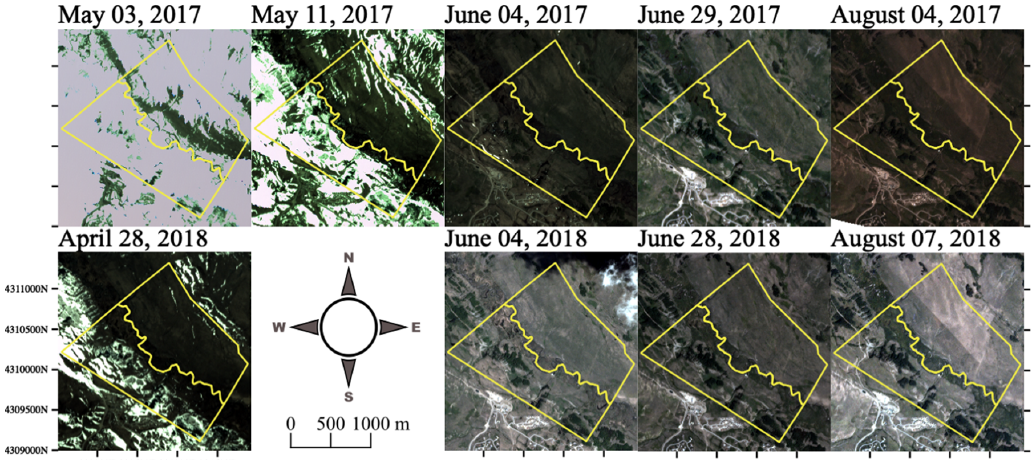
Figure 2. A portion of the time series of true color (RGB) satellite imagery with key dates in both years that show snow cover, plant growth, peak or near-peak plant productivity and senescence. Yellow lines outline the boundary between the north ( left ) and south ( right ) facing aspects. The full time series of images is included in the supplementary materials (Figure S1) along with the image IDs (Table S1). The coordinates displayed are NAD83, UTM zone 13N in meters.